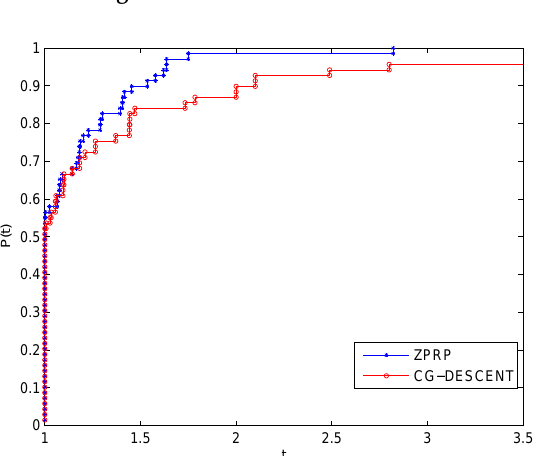
Figure 1. The number of iteration.